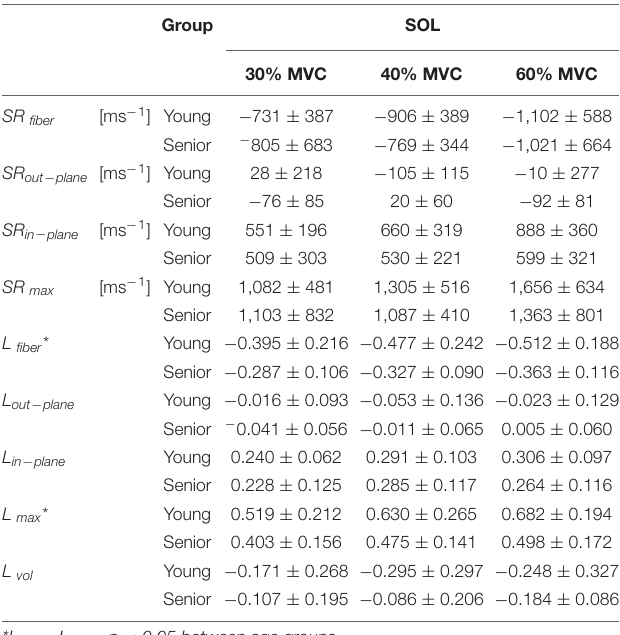
TABLE 1 | Peak strain rate and strain indices for a region of interest in the soleus averaged across young and senior subjects.